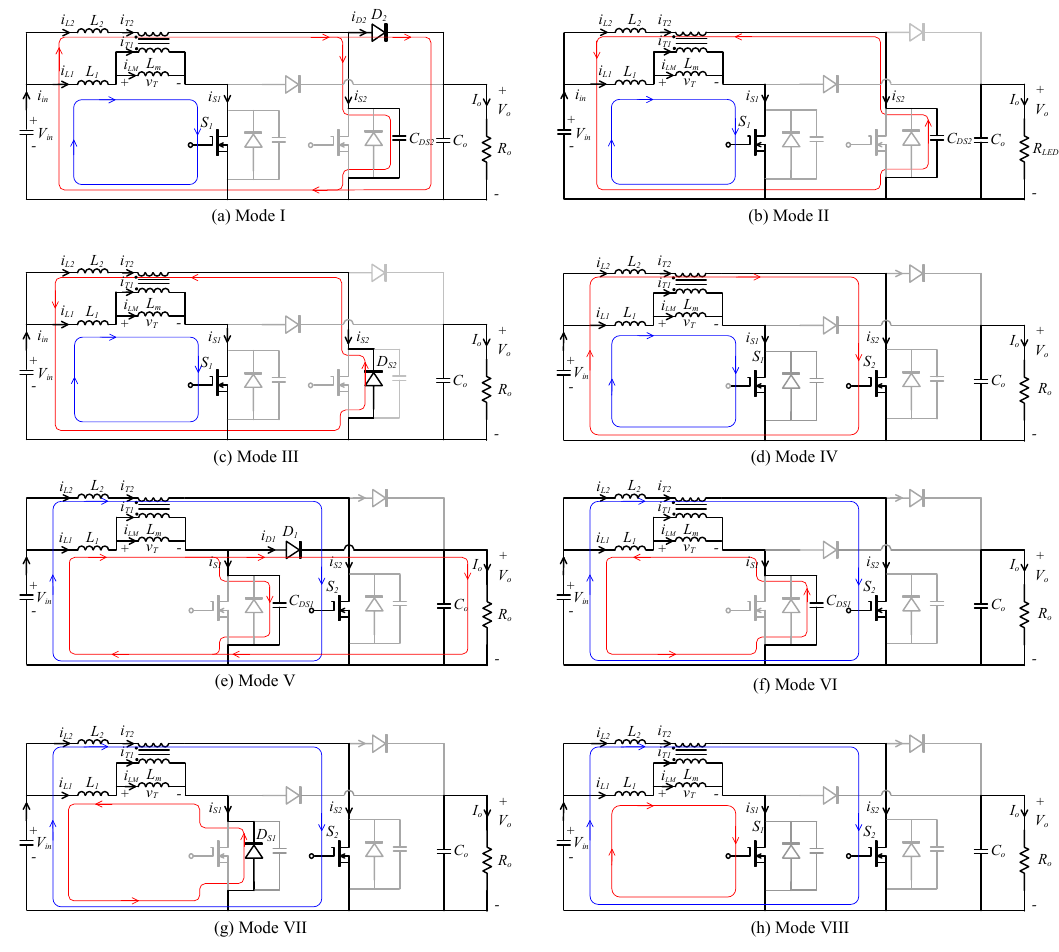
Figure 4. Operation modes.